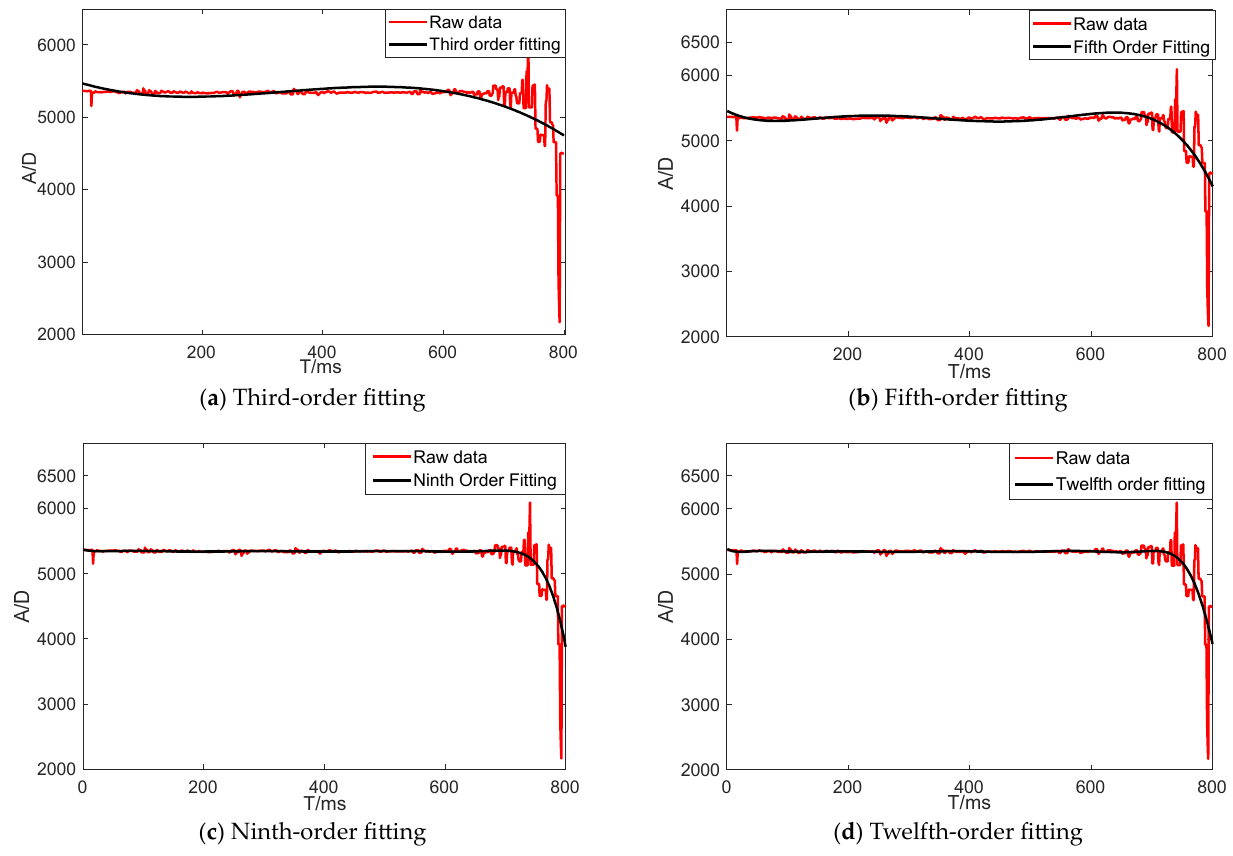
Figure 18. Polynomial fi t contrast diagram.